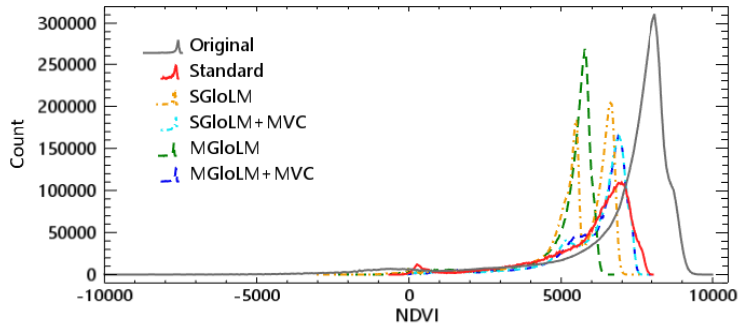
Figure 4 . Comparison of histograms before and after normalization.